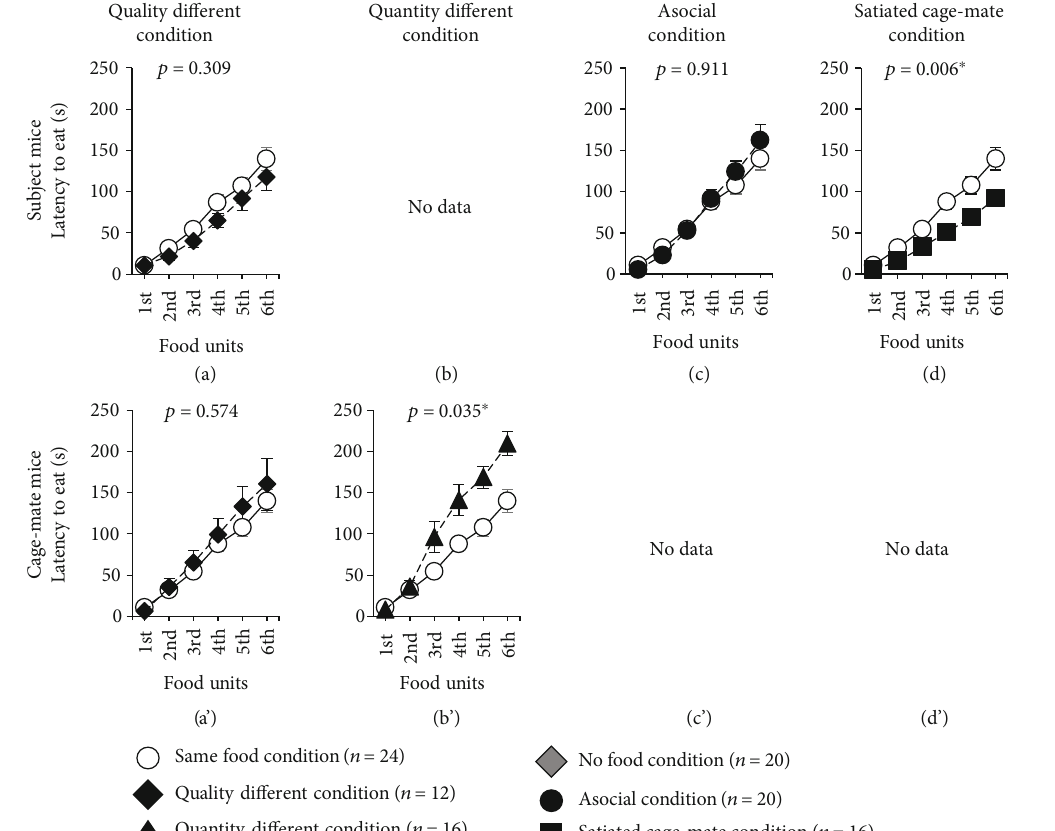
Figure 1: Comparison of the latency to begin eating 6 food units. Comparison of the latency to start eating the 6 food units in various conditions of the feeding behavioral test (same food condition, n = 24 ; quality di ff erent condition, n = 12 ; quantity di ff erent condition, n = 16 ; no food condition, n = 20 ; asocial condition, n = 20 ; stu ff ed cage-mate condition, n = 16 ). The upper row shows the subject mice ((a) – (d)), and the lower row shows the cage-mate mice ((a ′ ) – (d ′ )). Data are presented as means ± SEM . Statistical signi fi cance is represented by asterisks: ∗ p < 0 : 05 . The p values were calculated using a two-way repeated measures